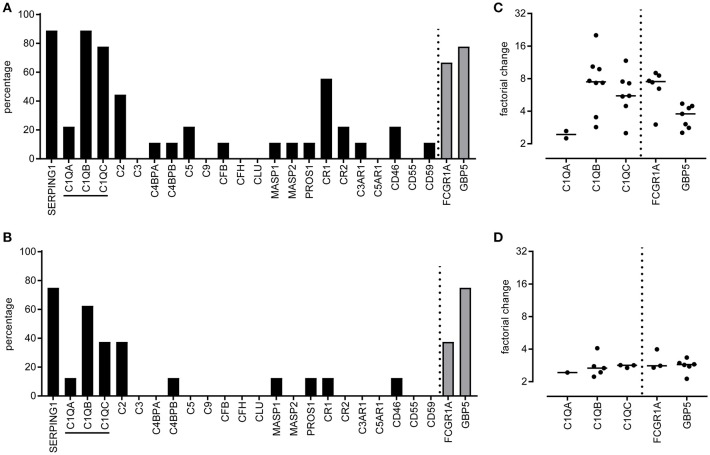
Differentially expressed complement genes in whole blood tuberculosis transcript signatures. Tuberculosis specific transcript signatures, from various populations, were investigated for the presence of differentially expressed complement genes using a tuberculosis RNA biomarker database. Publically available transcriptome data was retrieved from Gene Expression Omnibus (5–7, 33–37) and analyzed using GEO2R. Data were available for nine populations comparing active TB with LTBI and for 8 populations comparing active TB with other diseases. For each population we determined if the complement family genes were differentially expressed between TB and LTBI or other diseases. Differential expression was defined as an adjusted p-value <0.05 and more than 2-fold change. Differential expression of a gene between TB and LTBI or other diseases was expressed as percentage of the total number of populations investigated. The differential expression of complement genes was scored (A,B) as well as the mean factorial change for the C1q genes, C1QA, C1QB, and C1QC
(C,D) for the comparisons TB vs. LTBI (A,C) and TB vs. other diseases (B,D). As a reference two other highly upregulated potential diagnostic TB markers, FCGR1A, and GBP5, were included in the analyses.